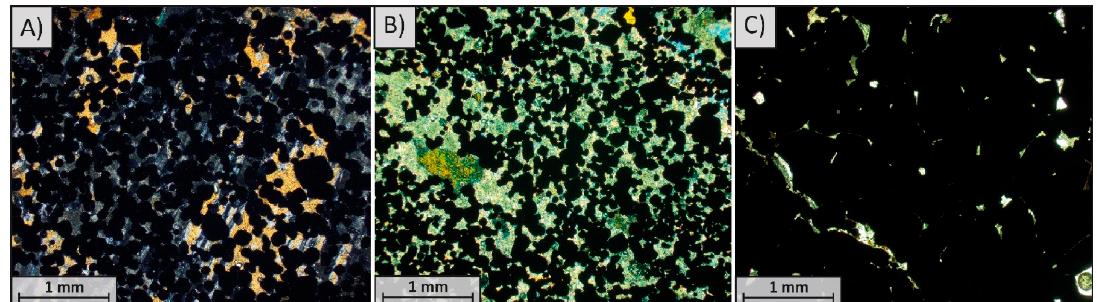
Figure 5. Cross-polarised photomicrographs of ( A ) Poikilitic Main Seam chromitite, sample 310.90a; plagioclase oikocrysts enclosing chromite crystals. ( B ) Leader Seam chromitite, sample 310.00a; a fine chromite fraction is associated with an interstitial cryptocrystalline matrix. ( C ) Leader Seam chromitite, sample 310.00a; densely packed accumulations of relatively coarse chromite crystals.